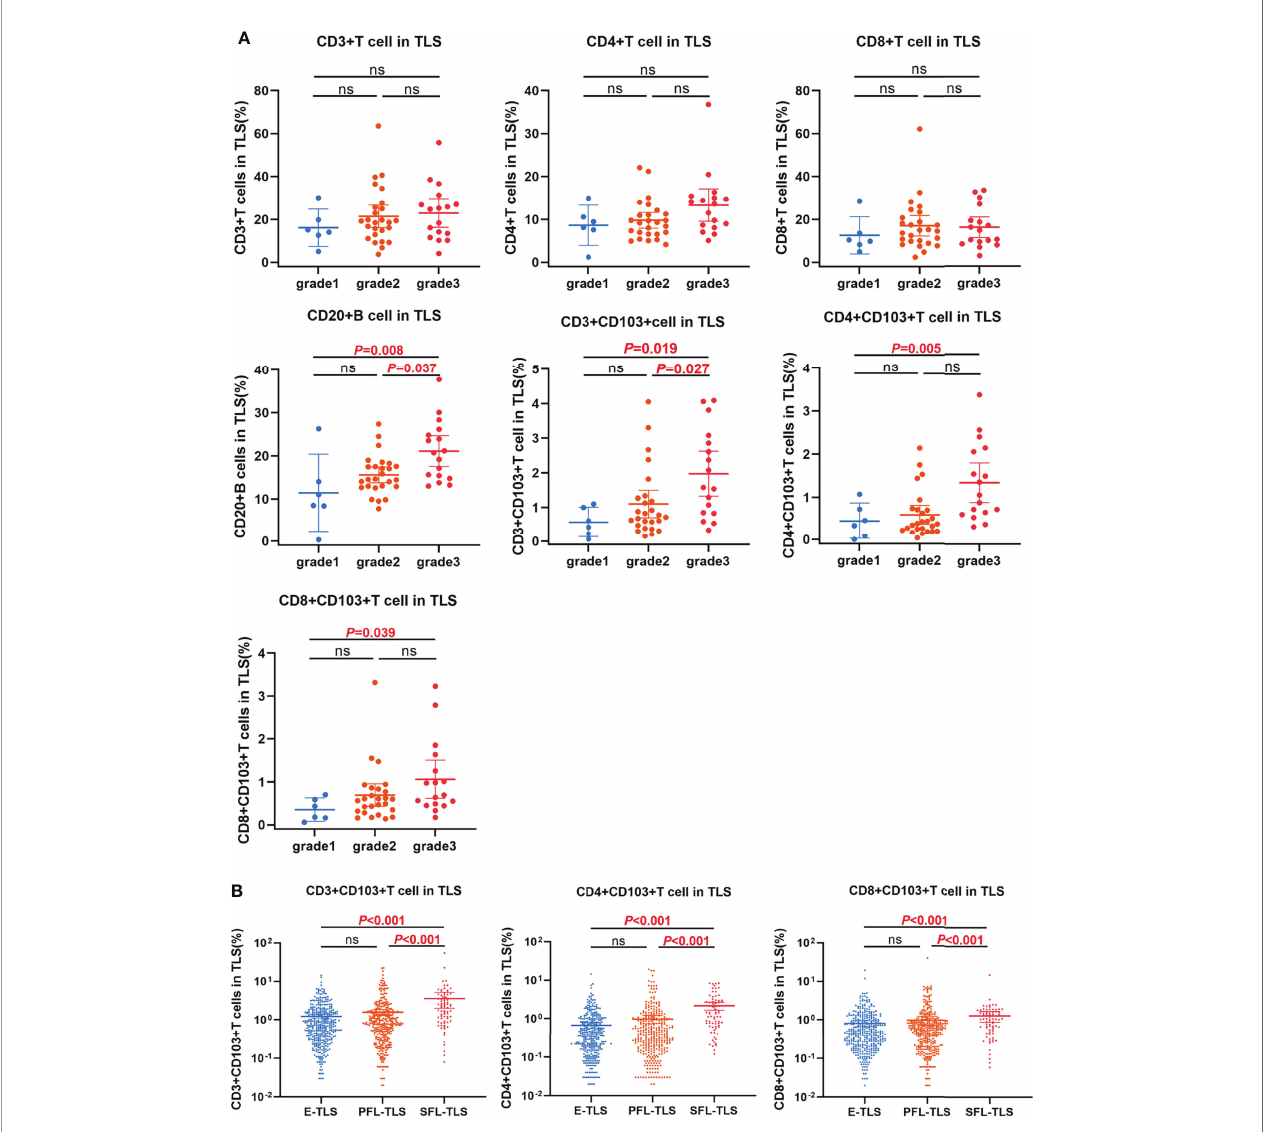
FIGURE 4 | The relationship between T RM distribution and TLSs maturation. (A) The distributions of immune subsets within TLS in patients with different TLS scores. The proportion of CD20 + B cell and CD3 + CD103 + T RM within TLS in grade 3 patients was signi fi cantly higher than that in grade 2 and grade 1 respectively. The proportion of CD4 + CD103 + T RM and CD8 + CD103 + T RM within TLS in grade 3 patients was signi fi cantly higher than that in grade 1. (B) The distribution of T RM in E-TLS, PFL-TLS, and SFL-TLS. The proportions of CD3 + CD103 + T RM , CD4 + CD103 + T RM , and CD8 + CD103 + T RM within SFL-TLS were signi fi cantly higher than those in E-TLS and PFL-TLS, respectively. ns, non-signi fi